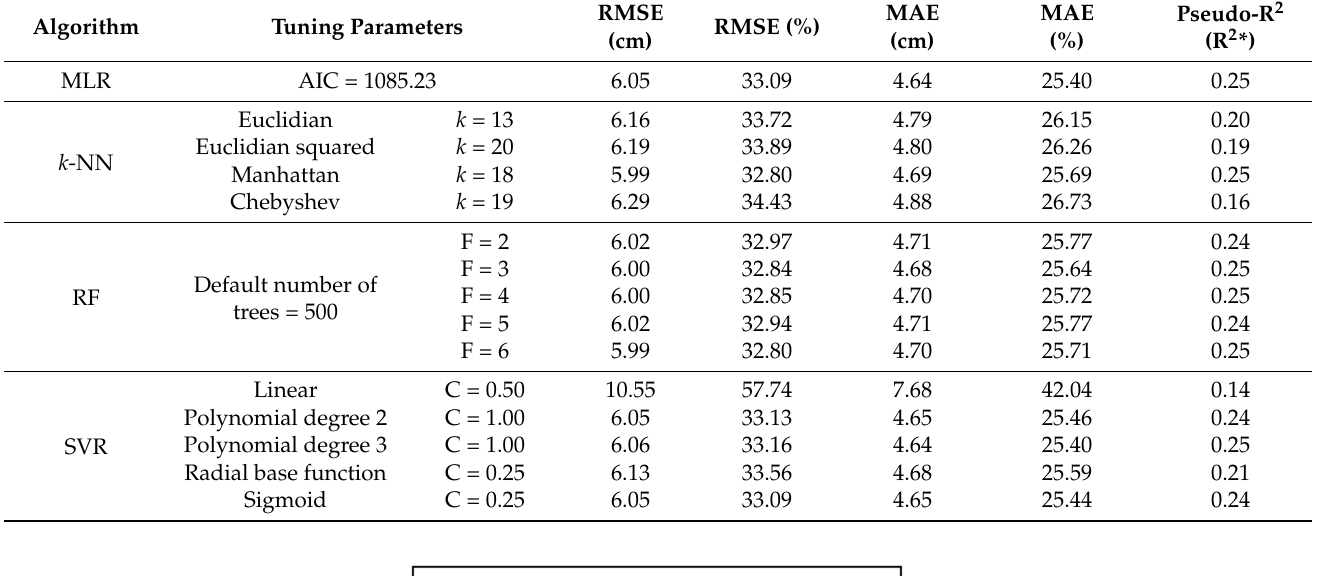
Table 4. Prediction accuracy of the standard deviation of dbh ( σ dbh ) using multiple linear regression (MLR), k -nearest neighbors ( k -NN), random forest (RF), and support vector regression (SVR) algorithms.